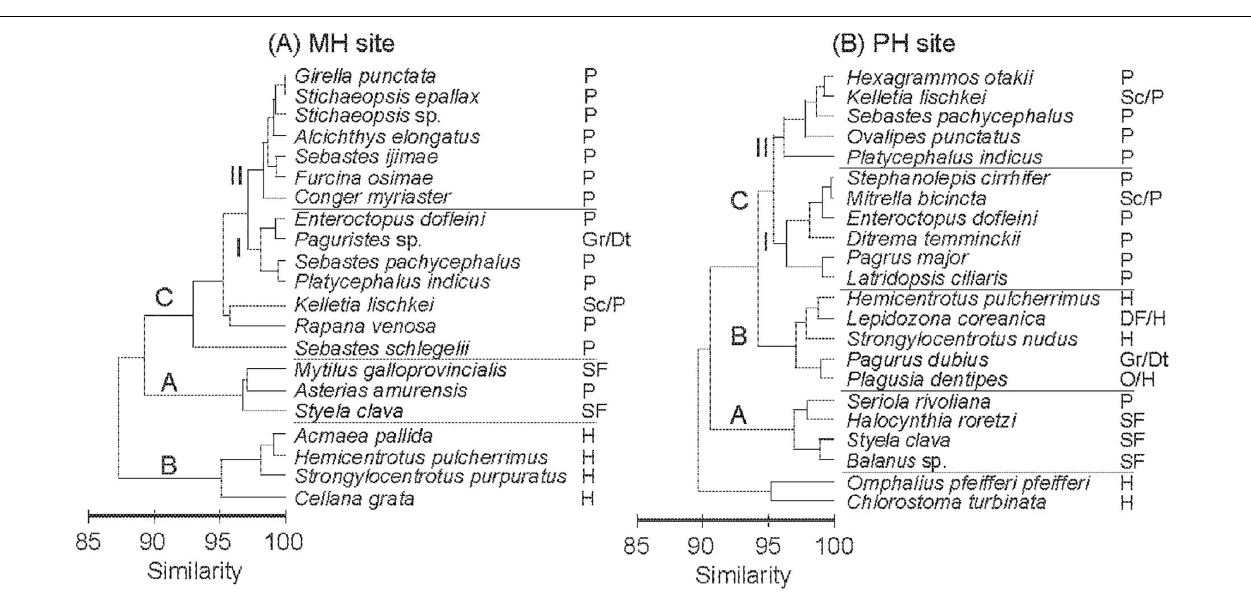
FIGURE 4 | Hierarchical clustering of the average δ 13 C and δ 15 N values of consumers at the MH (A) and PH (B) sites using Bray–Curtis similarity (average grouping method). Trophic groups: SF, suspension feeder; G/Dt, grazers/detritus feeders; DF, deposit feeders; H, herbivores; O, omnivores; P, predators; and Sc/P,